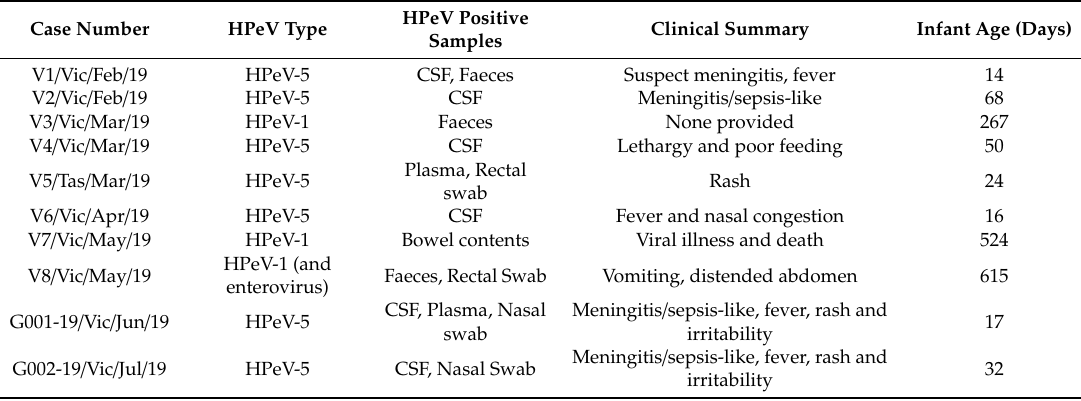
Table 1. Clinical details of the human parechovirus (HPeV)-positive cases between February and July 2019 in Southeastern